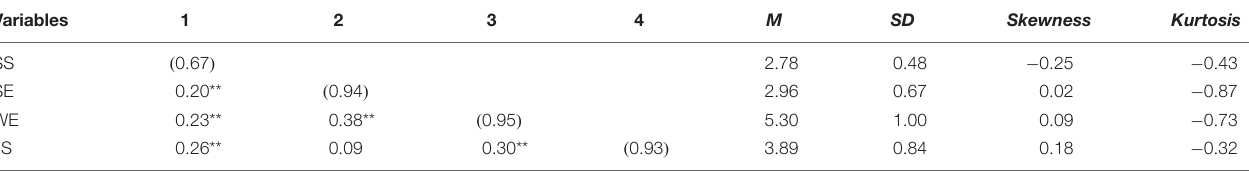
TABLE 3 | Correlations of variables.